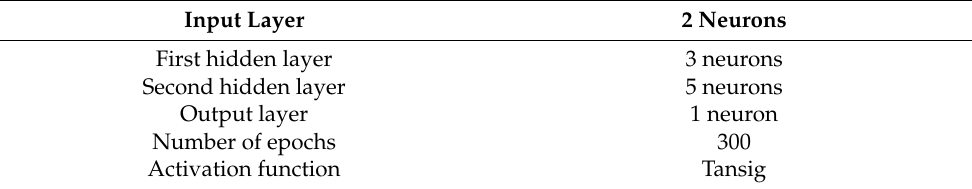
Table 2. Network characteristics for void fraction measurement.